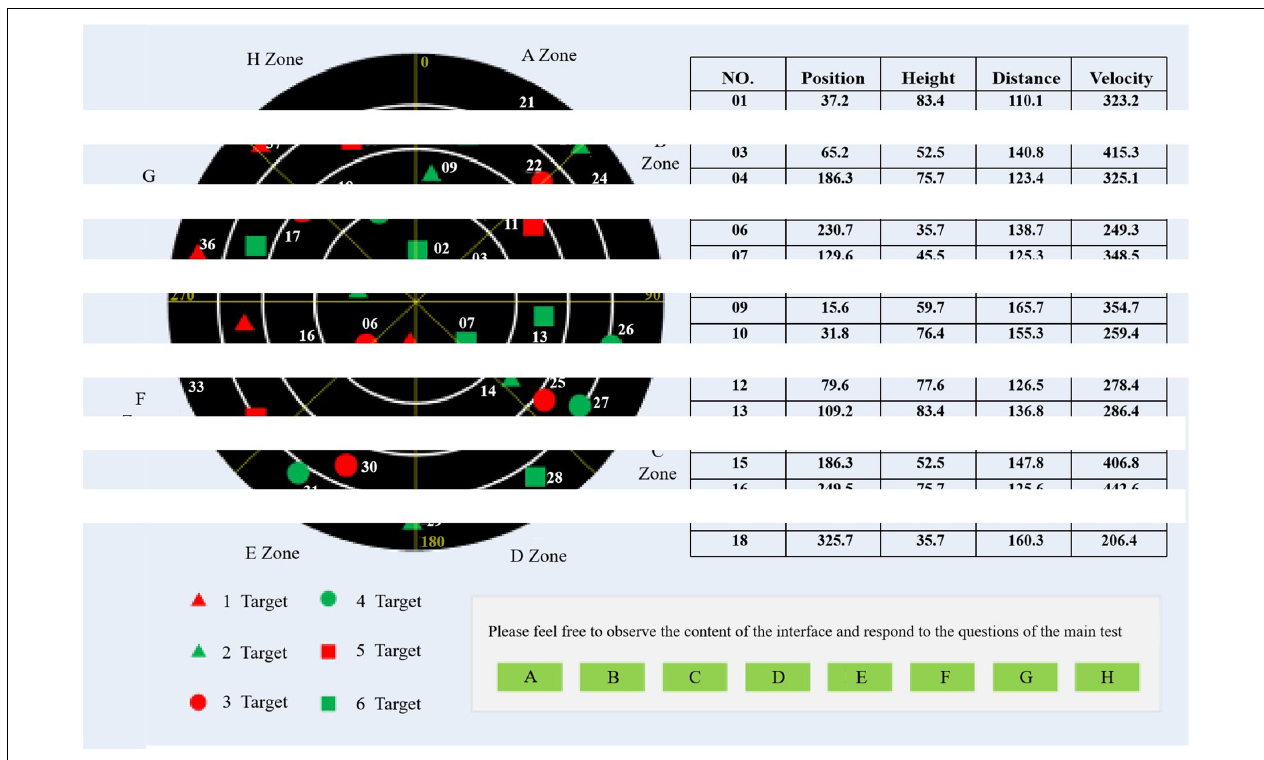
FIGURE 6 | Stress state experimental